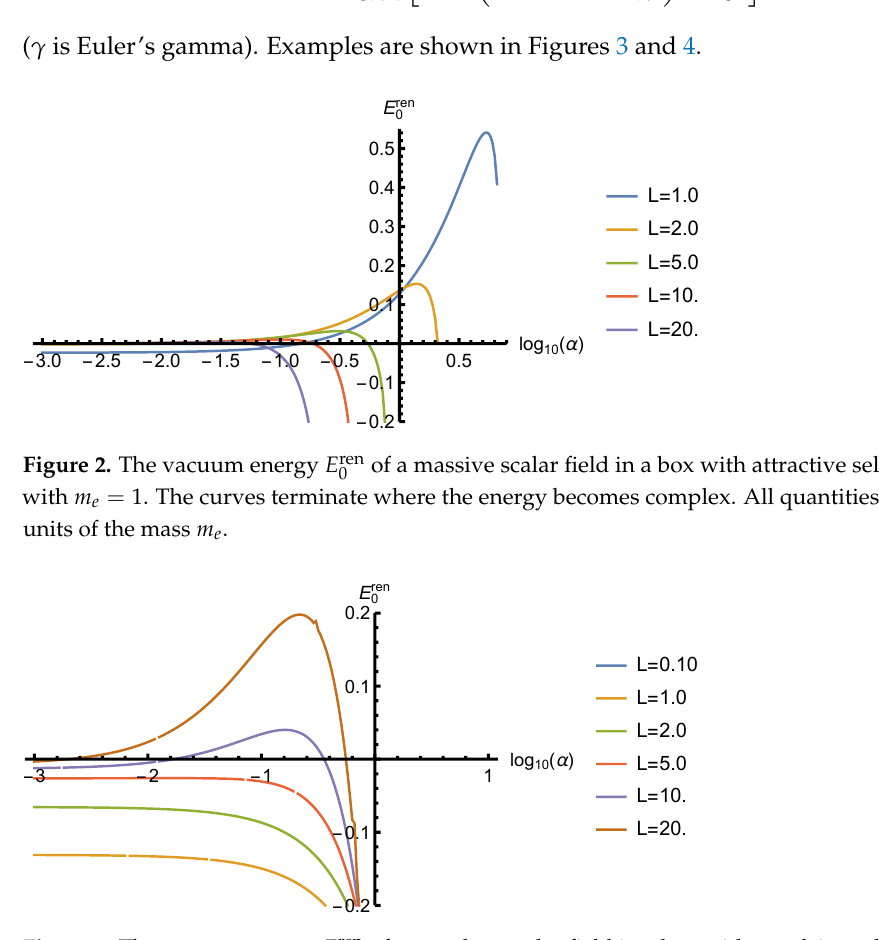
Figure 3. The vacuum energy E ren of a massless scalar field in a box with repulsive self-interaction 0 and µ = 1. E ren and α are given in units of µ 0